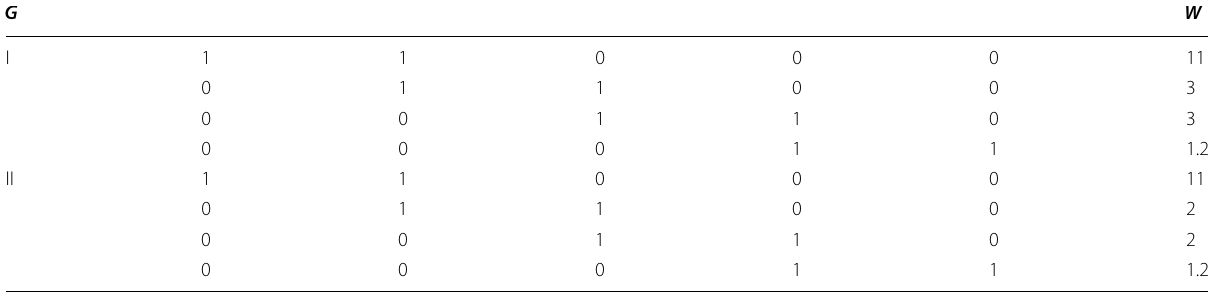
Table 3 Inequality constraint data for the second example G